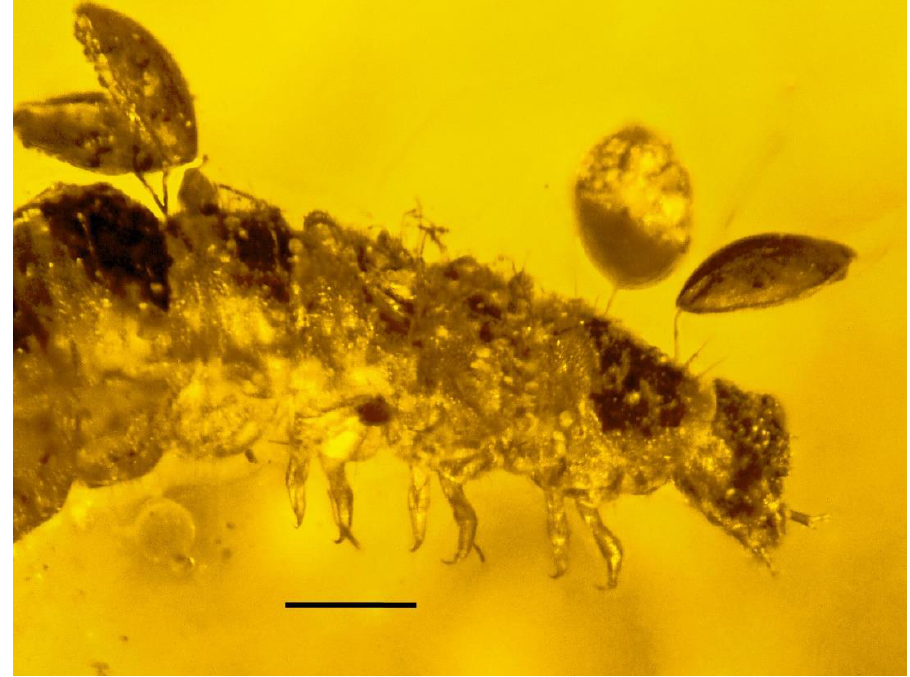
Figure 7. Detail of hardened glue sticks attaching phoretic mites (Arachnida: Acari) to the beetle larva in Figure 6. Scale bar = 75 µm.